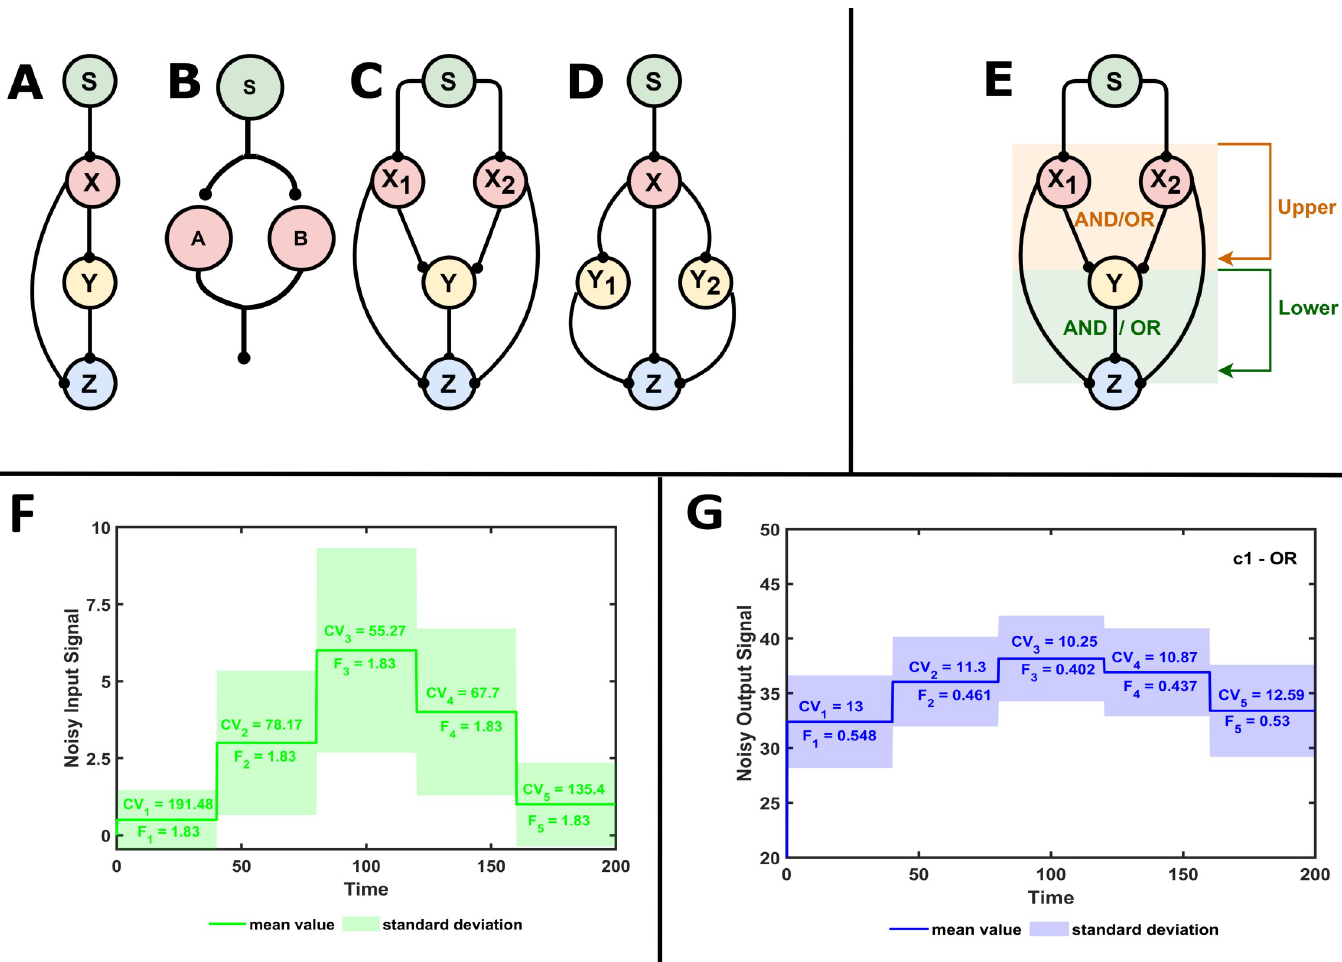
Fig 1. Network motifs and the input-output test ran on them. Feed-forward loop (A), annihilation module (B), combination of feed-forward loops, which contain traces of the annihilation module: multi-input coupled feed-forward loop (minp-FFL) (C) and multi-intermediate coupled feed-forward loop (mint-FFL) (D)–pointed-end arrows can stand for activating or inhibiting interactions. AND or OR logical gates are considered for all FFL models, but in minp-FFL logic gates function at two separate levels leading to 4 possible systems: fully AND, fully OR, upper-AND-lower-OR (uAND-lOR) and upper-OR-lower-AND (uOR-lAND) (E). In all models, the input signal ( S ) was driven by super-Poissonian noise (the coefficient of variation in percentage (% CV) at all average input values is presented and the resulting Fano factor of 1.83 at all average input levels is also noted.) (F). The average output level and the noise of the output species Z was registered for all input levels, leading to reduced Fano factor and coefficient of variation (% CV) values, which still depend on the average input level